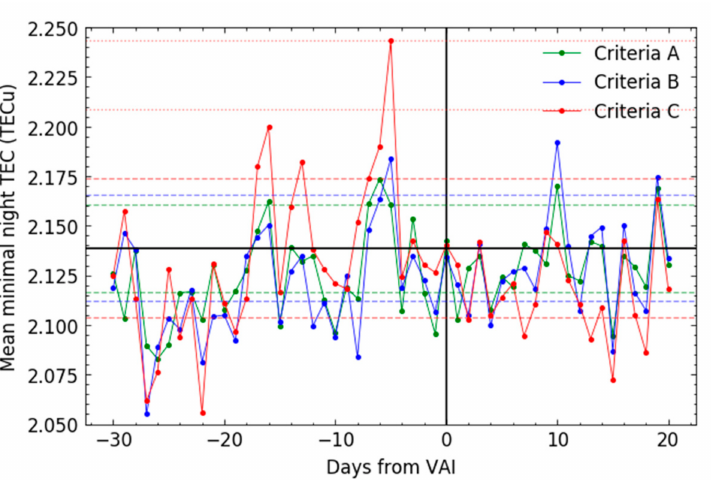
Figure 5. Mean values of minimal night TEC at IGS Noto for Criteria A (green), B (blue) and C (red). The vertical line denotes the day of volcanic activity increase. Mean +/ − 1 standard deviation for respective criteria is added with dashed line of the same colour, and for Criteria C, mean +2 and +3 standard deviations are added as red dotted lines.